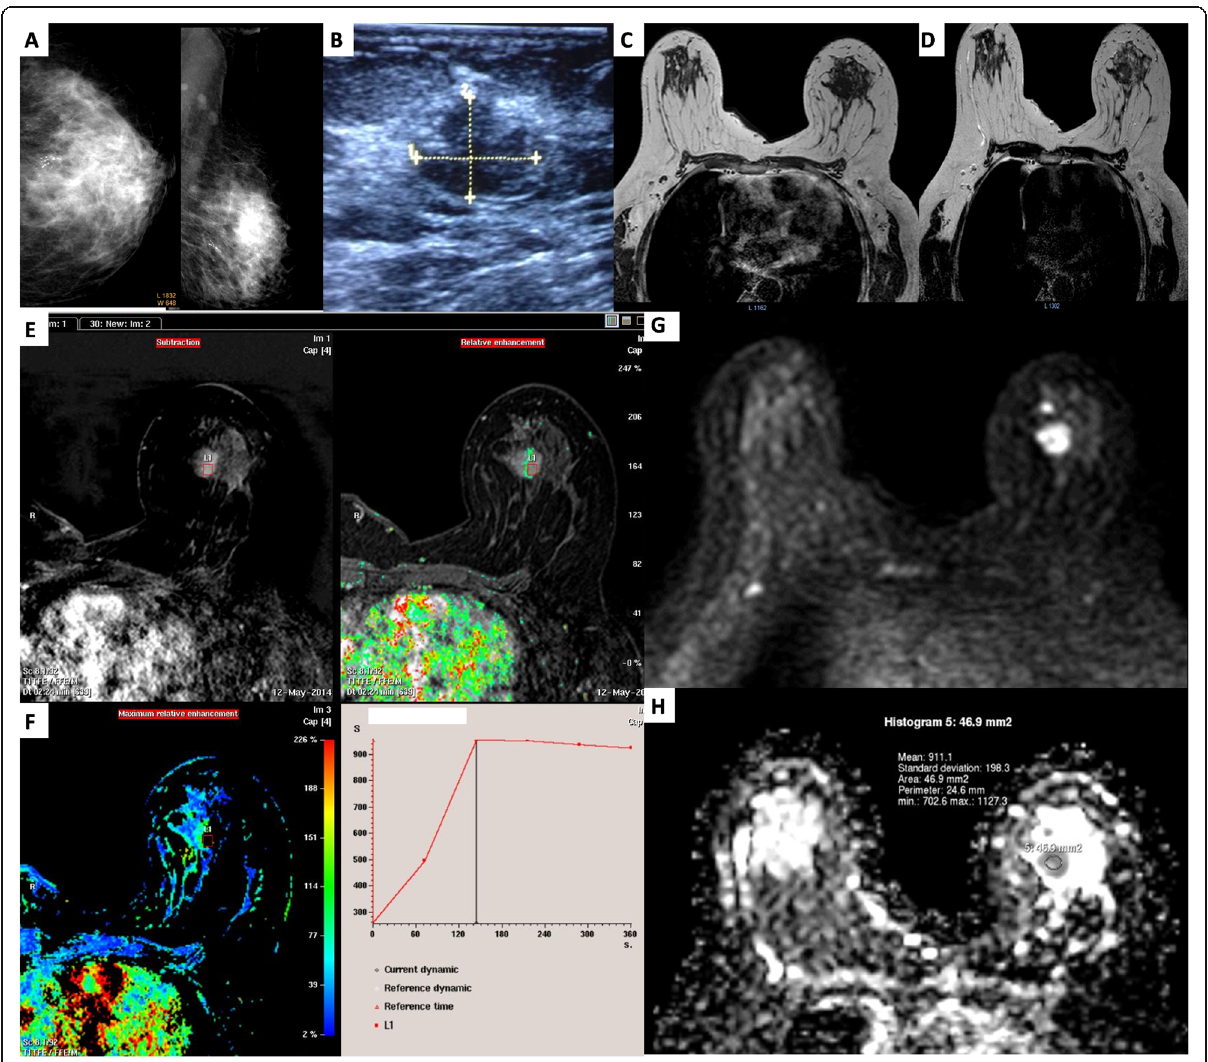
Fig. 4 A 49-year-old female patient presented with left breast lump. Mammography ( A ) showed left upper central focal asymmetry with mild architectural distortion and linear clustered calcification. Ultrasound ( B ) showed left 12 o ’ clock irregular hypoechoic lesion. Sonomammography revealed BIRADS 4. MRI axial images showed left upper central microlobulated lesion of intermediate T1 ( C ) and T2 signal intensity ( D ). MRI axial dynamic THRIVE sequence and subtraction image ( E ) showed left upper central microlobulated heterogeneously enhancing mass with a small nearby (anterior) suspected ring enhancing nodule. Time/signal intensity analysis of ROI ( F ) showed plateau curve pattern (type II) with SI % of 270%. Diffusion sequence b 850 ( G ) and post-processing ADC map ( H ) showed restricted diffusion with more evident anterior restricted nodule. ADC value for ROI was 0.9 × 10 − 3 mm 2 /s. DCE-MRI and DWI-MRI revealed BIRADS 5 and suspicious findings. Pathology revealed invasive ductal